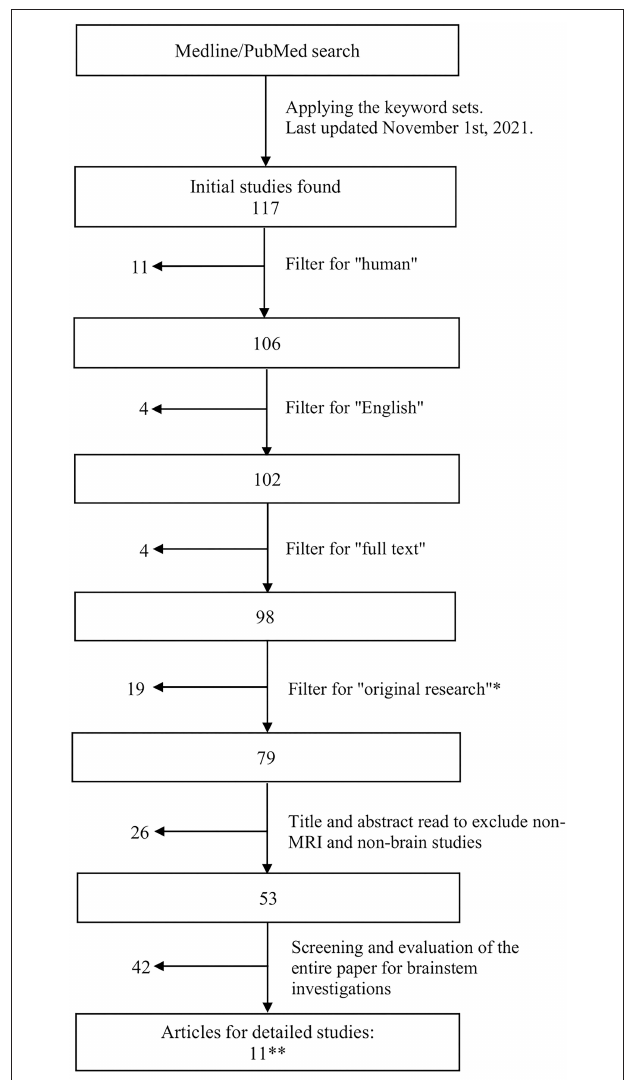
FIGURE 1 | Flowchart showing the literature search and article retrieval process. *Included papers that had original findings, including case reports. **The search revealed a final set of 11 original research studies, none of which were case